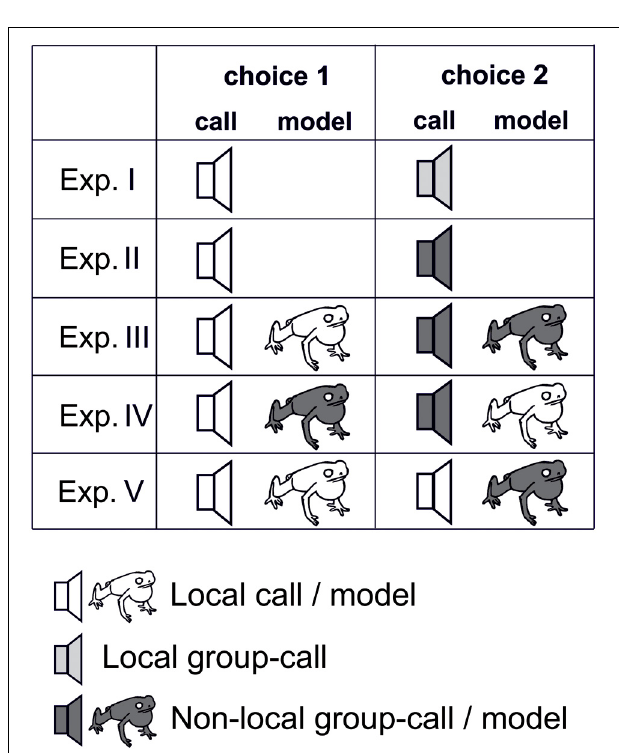
FIGURE 3 | Experimental types used for playback experiments. Type I and II unimodal experiments with different call sequences (indicated by loudspeaker symbol) on both sides; type III–V bimodal experiments with different combinations of call sequences and local and non-local model frogs (indicated by frog symbol). (White, local call/ local model; light gray, local group call; dark gray, non-local group call/non-local